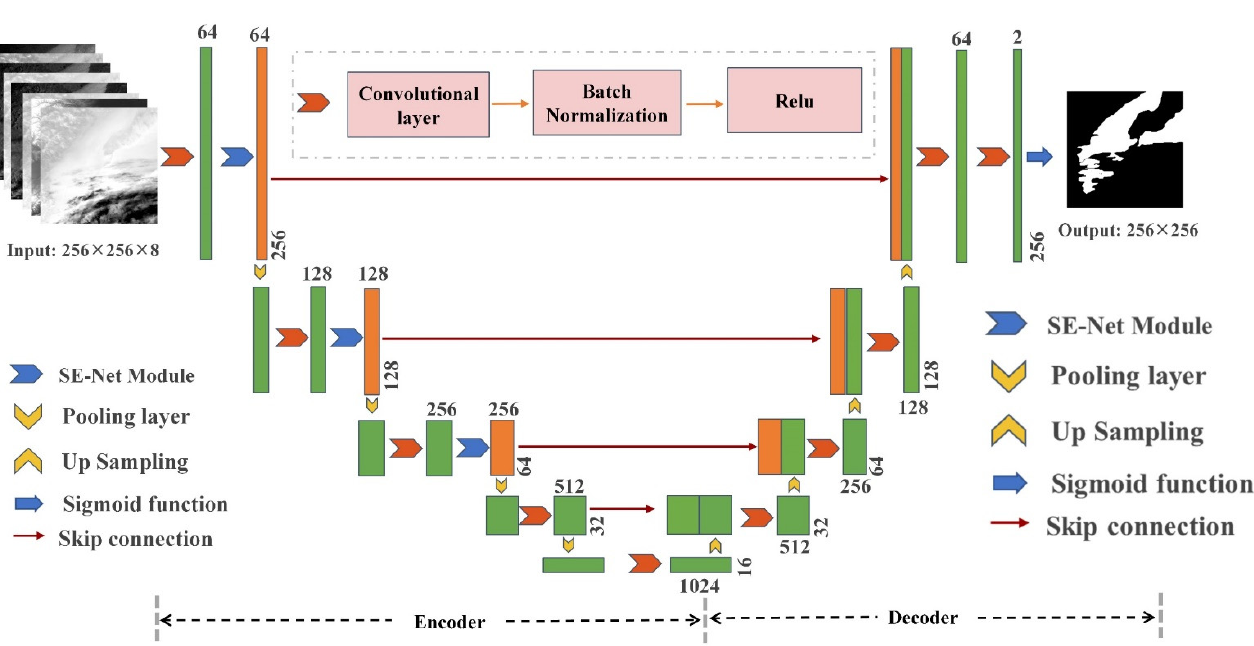
Figure 4. The DDF-Net’s architecture. The top/bottom numbers of the rectangle represent the channels of the feature map, and the right numbers are the size of the feature map.